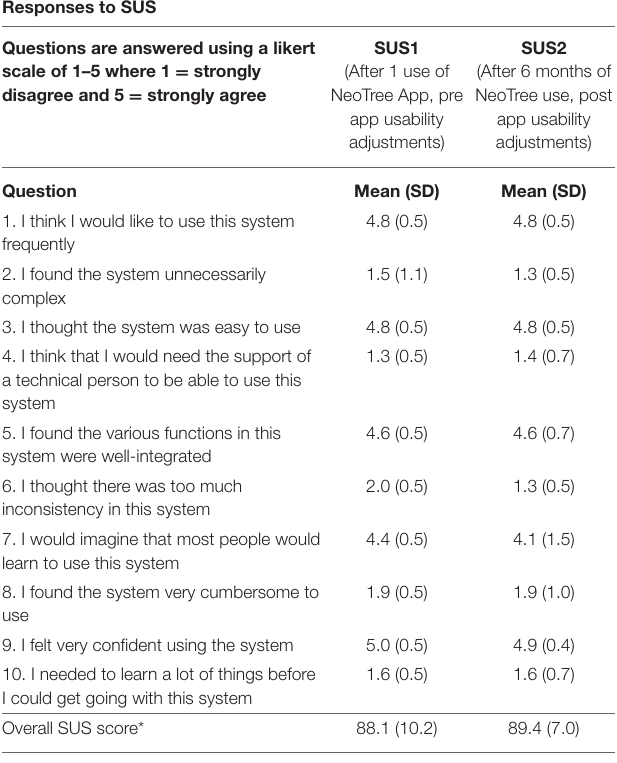
TABLE 7 | SUS responses and scores. Responses to